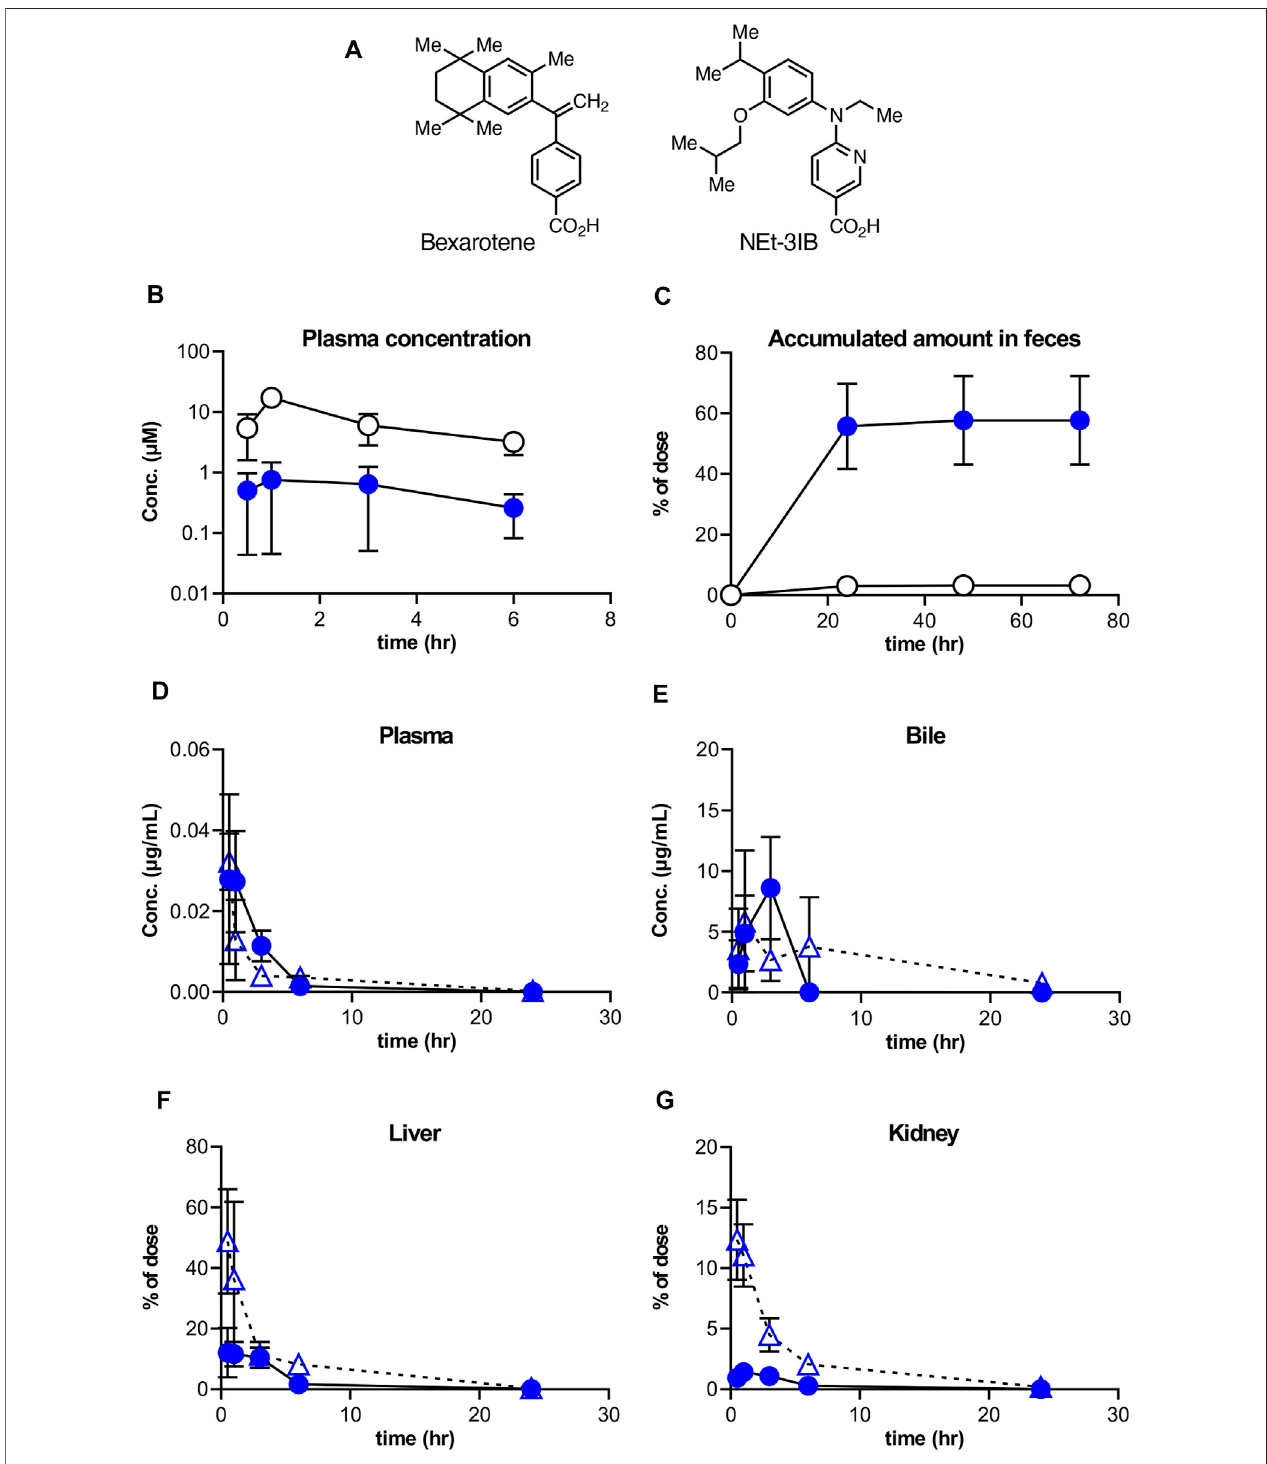
FIGURE 1 | Distribution of NEt-3IB after a single dosage to male mice. (A, B) Concentration of bexarotene or NEt-3IB in plasma and feces, respectively. Each compound wasorally administered at (A) 30 mg/kg and (B) 10 mg/kg. (C – F) Plasma, bile,liver, and kidneydistributionofNEt-3IB after single administration at 1 mg/kg ( i.v .) and 10 mg/kg (p.o.). Circles and triangles show p.o. and i,v. data, respectively. Data shown are mean [ n (cid:2) 5 (A, C – F) or 3 (B) ] ± SD.